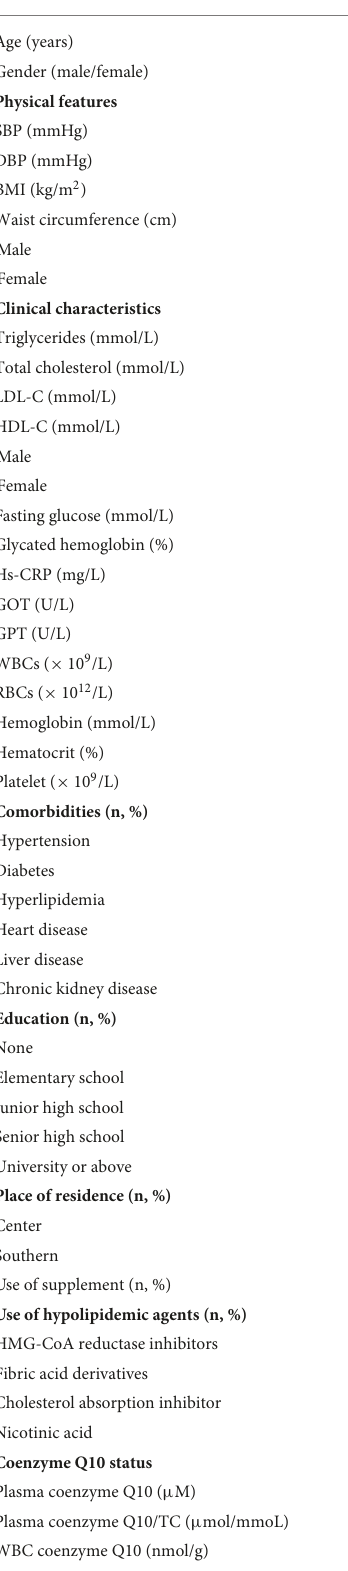
TABLE 1 Demographic data and coenzyme Q10 status in patients with dementia.